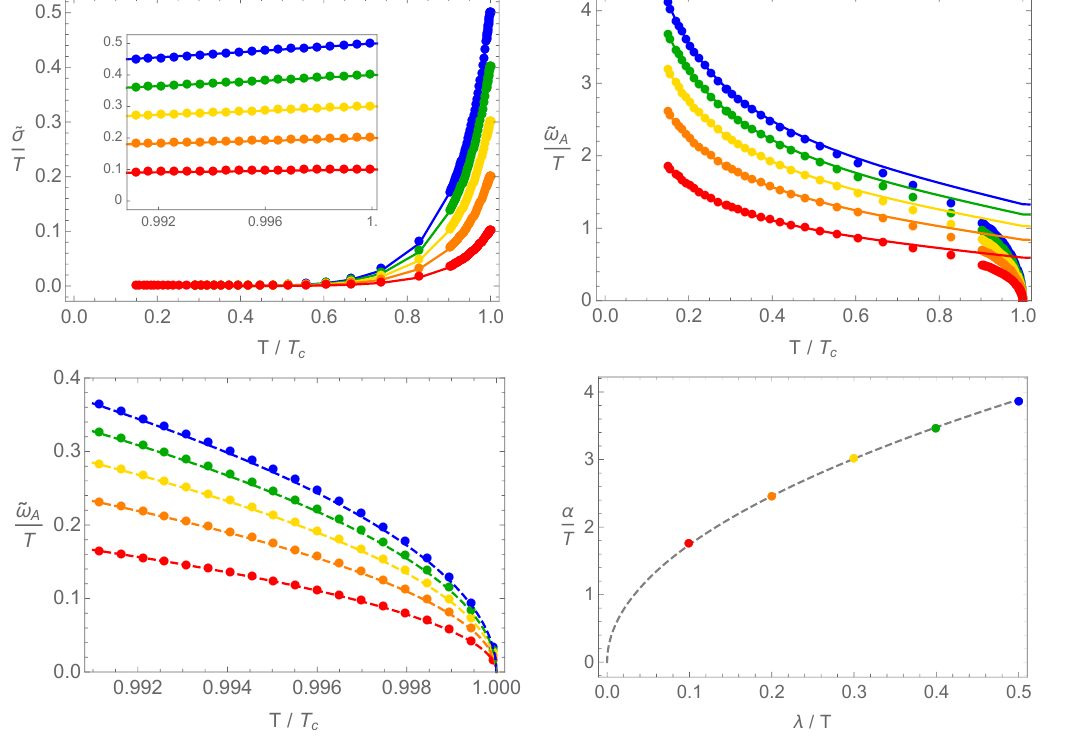
Figure 8 . The phenomenological parameters appearing in the dispersion relation of the lowest QNMs in the transverse sector at k = 0 . Different colors from red to blue correspond to λ/T = 0 . 1 − 0 . 5 . Top left: the conductivity ˜ σ and the expression in eq. (5.9) (solid lines). Top right: the phenomenological mass ˜ ω together with the plasma frequency value in eq. (5.11) (solid lines). Bottom left: the A behavior of the mass close to the critical point, T ∼ T and the fitting formula in eq. (5.12) (dashed c lines). Bottom right: the phenomenological parameter α as a function of the EM coupling. The dashed line is the fitting formula α/T = 5 . 5 p λ/T